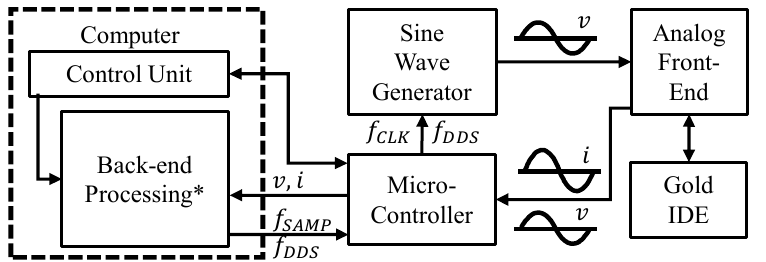
Figure 2. Functional diagram of the low-cost impedance analyzer device, adapted from [17]. * For more information on the back-end processing, see